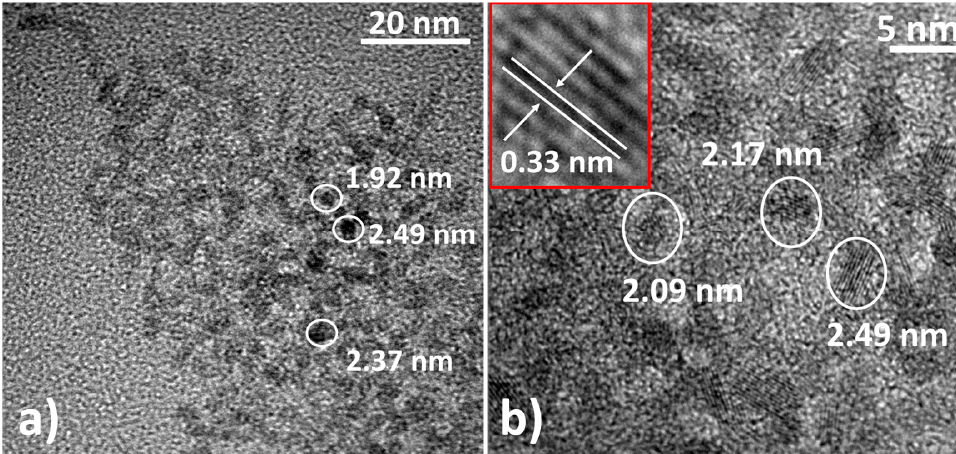
Figure 4. TEM micrographs of SnO 2 QDs synthesized via a solvothermal route at a magnification of ( a ) 40 kX and ( b ) 1500 kX. The inset image in ( b ) shows the fringes and d-spacing of SnO 2 QDs.